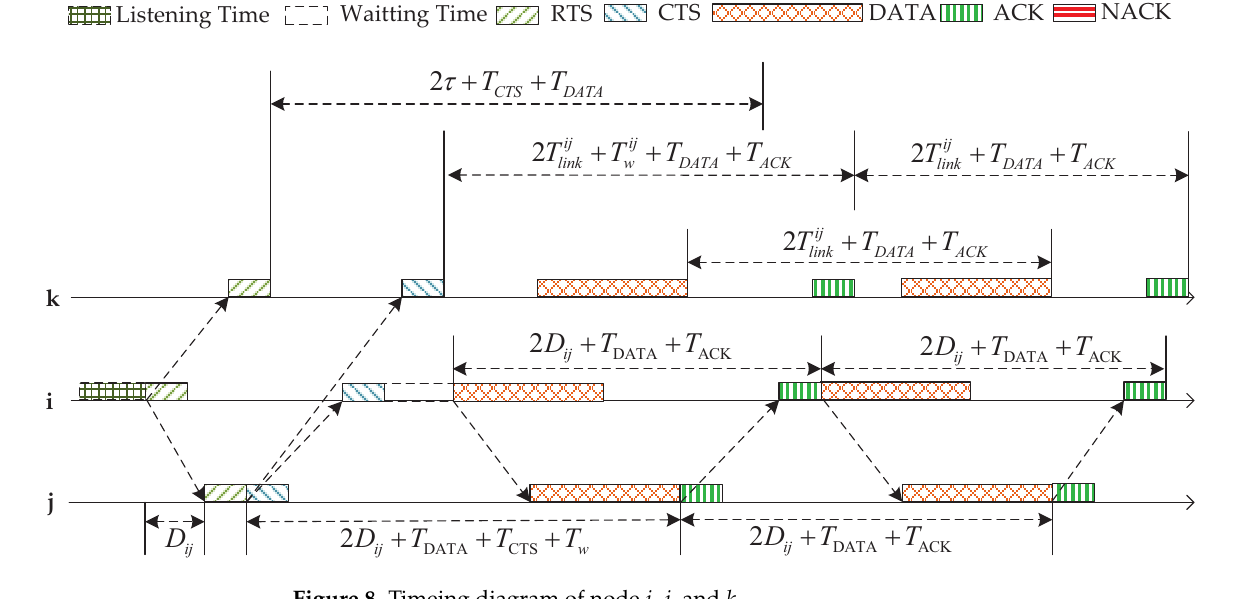
Figure 8. Timeing diagram of node i , j , and k